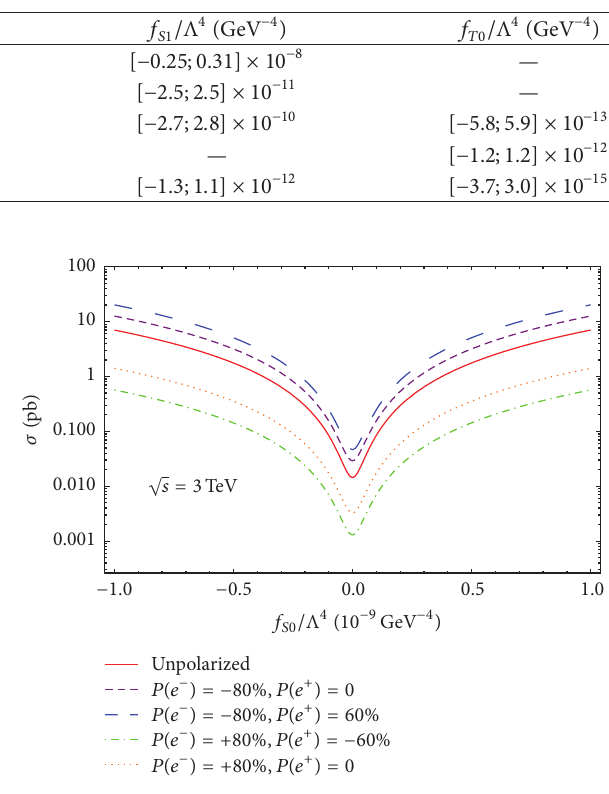
Figure 3: The total cross section for 𝑒 + 𝑒 − → ] 𝑒 𝑊 − 𝑊 + ] 𝑒 processes as a function of 𝑓 𝑆0 /Λ 4 at the √𝑠 = 3 TeV for different polarization of the positron and electron beams.